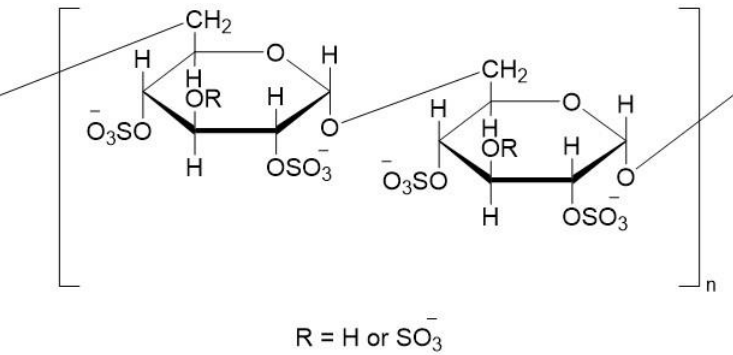
Figure 1. Chemical structure of DXS.